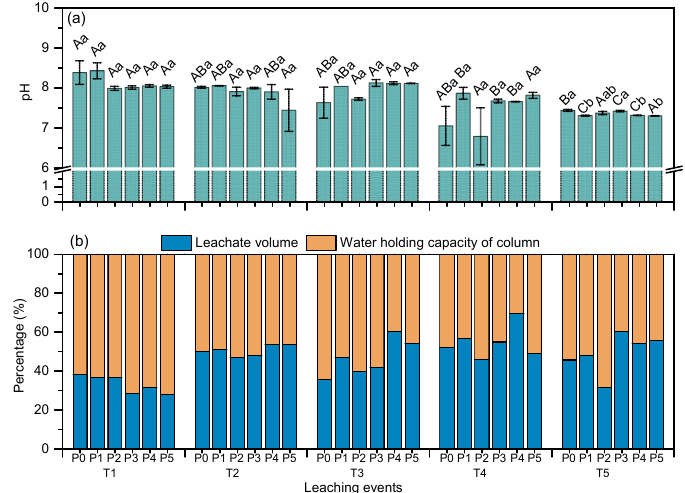
Figure 4. pH in leachate ( a ) and the percentage of leachate and water-holding capacity ( b ) at different treatments. Phosphorus fertilizer levels at 0 (P0), 20 (P1), 40 (P2), 100 (P3), 200 (P4), and 400 (P5) mg kg − 1 , respectively, and the soil columns were conducted at 7 days (T1), 14 days (T2), 21 days (T3), 28 days (T4), and 56 days (T5). Different capital letters above the bars indicate significant differences among different times ( p < 0.05). Different lowercase above the bars indicate significant differences among different P levels ( p <